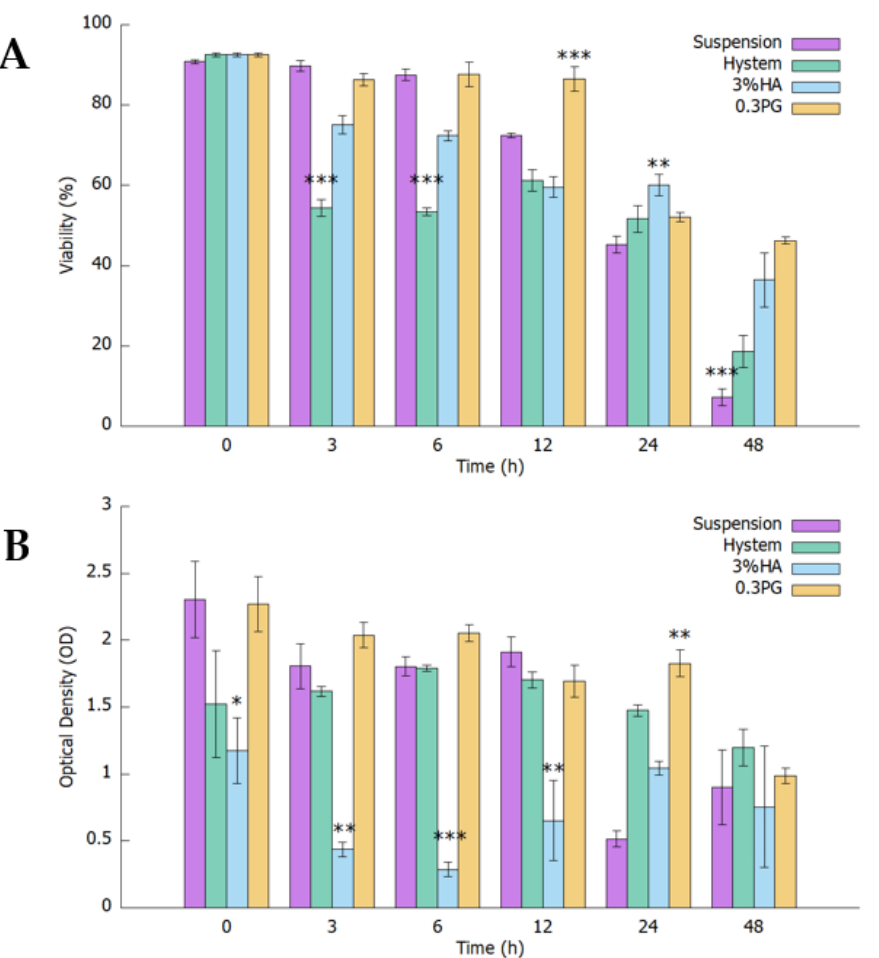
Figure 1. After encapsulation with no culture medium provided, CCK8 and viability of hADMSCs in different 3D conditions measured at different time points. ( A ) CCK8 results were recorded as increase in optical density (OD) at each time point (OD after 1 h CCK8 incubation—OD right after CCK8 addition); ( B ) Percent viability at each time point measured with cellometer. All results are shown as mean ± standard error of the mean (SEM), * p < 0.05, ** p < 0.01, *** p < 0.001.